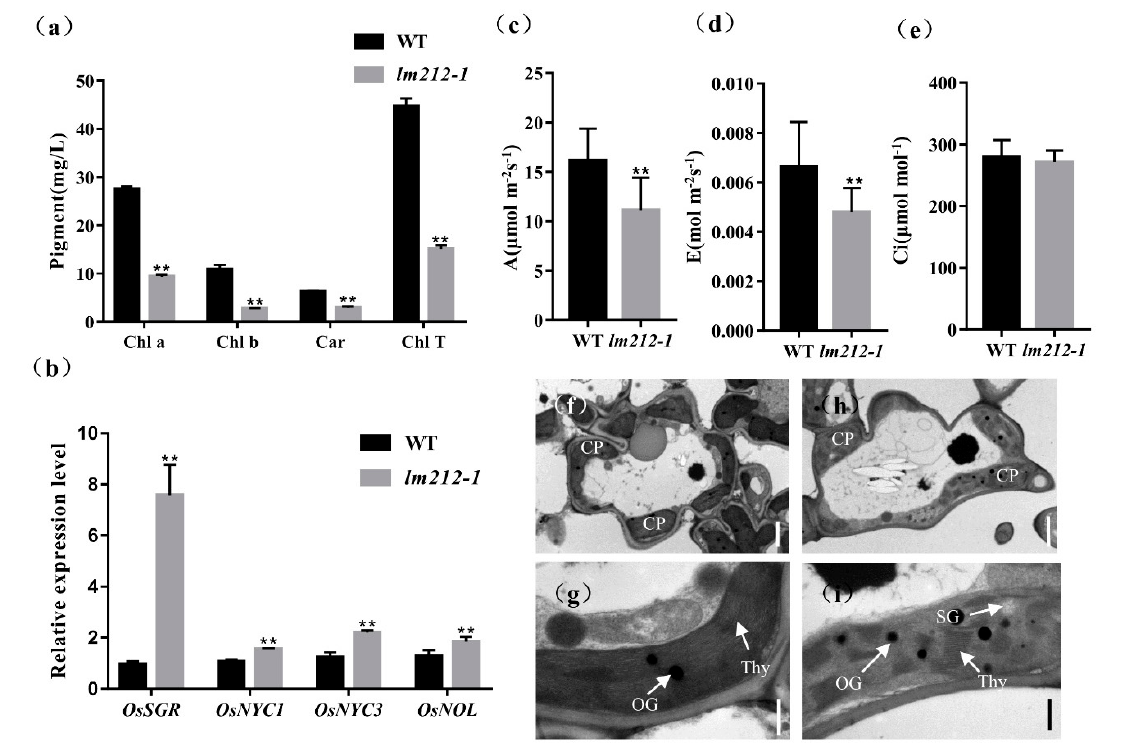
Figure 2. Determination of chlorophyll (Chl) content, photosynthetic rate, expression of genes associated with chloroplast degradation, and ultrastructural analysis of chloroplasts. ( a ) The Chl content at the tillering stage. ( b ) Expression analysis of chloroplast degradation-related genes in the WT and lm212-1 leaves. ( c ) Net photosynthetic rate (A) at the heading stage. ( d ) Transpiration rate (E) at the heading stage. ( e ) Intercellular CO 2 concentration (Ci) at the heading stage. ( f – i ) Transmission electron microscopy of chloroplasts in WT leaves and lm212-1 leaves. ( f , g ), WT leaves. ( h , i ) lm212-1 leaves. Cp, chloroplast; SG, starch granule; Thy, thylakoid; OG, osmiophilic granule. Scale bar: 2 µ m in ( f , h ), 0.5 µ m in ( g , i ). ** p < 0.01 by the Student’s t -test. Data represent means ± SD of three biological